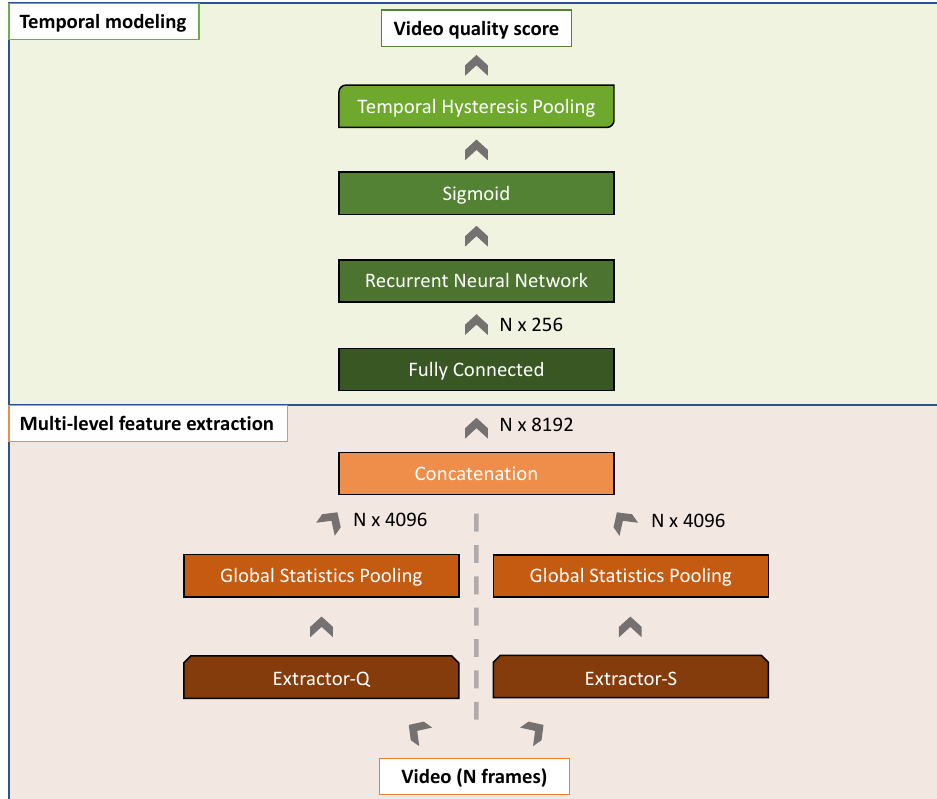
Figure 1. The proposed Quality and Semantics Aware Video Quality Method (QSA-VQM). The QSA-VQM consists of two main blocks: the Multi-level feature extraction and the Temporal modeling. The Multi-level feature extraction block encodes each video frame in terms of both quality and semantic features. The Temporal modeling block maps frame-level feature vectors into a frame-level quality score using a Recurrent Neural Network (RNN) and then combines all the quality scores thanks to a Temporal Hysteresis Pooling.